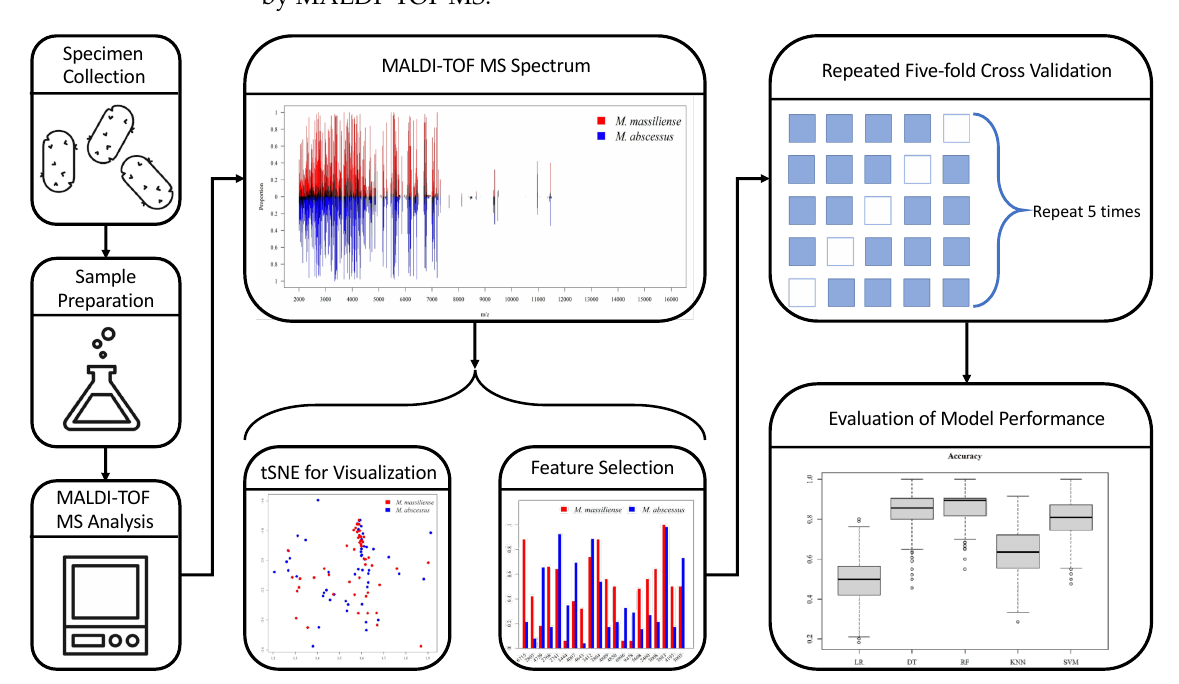
Figure 2. Scheme of the research workflow. MABC isolates are analyzed by MALDI–TOF to retrieve MS spectra as the input. The subspecies classification for the MABC isolates are labeled according to DNA sequencing of the marker genes (i.e., secA1 , rpoB , and hsp65 ). The MS spectra are analyzed and visualized prior to modeling. Informative features are also illustrated among the subspecies. We train and validate the models using repeated five-fold cross-validation to avoid over-fitting. Performance metrics of different algorithms are calculated and